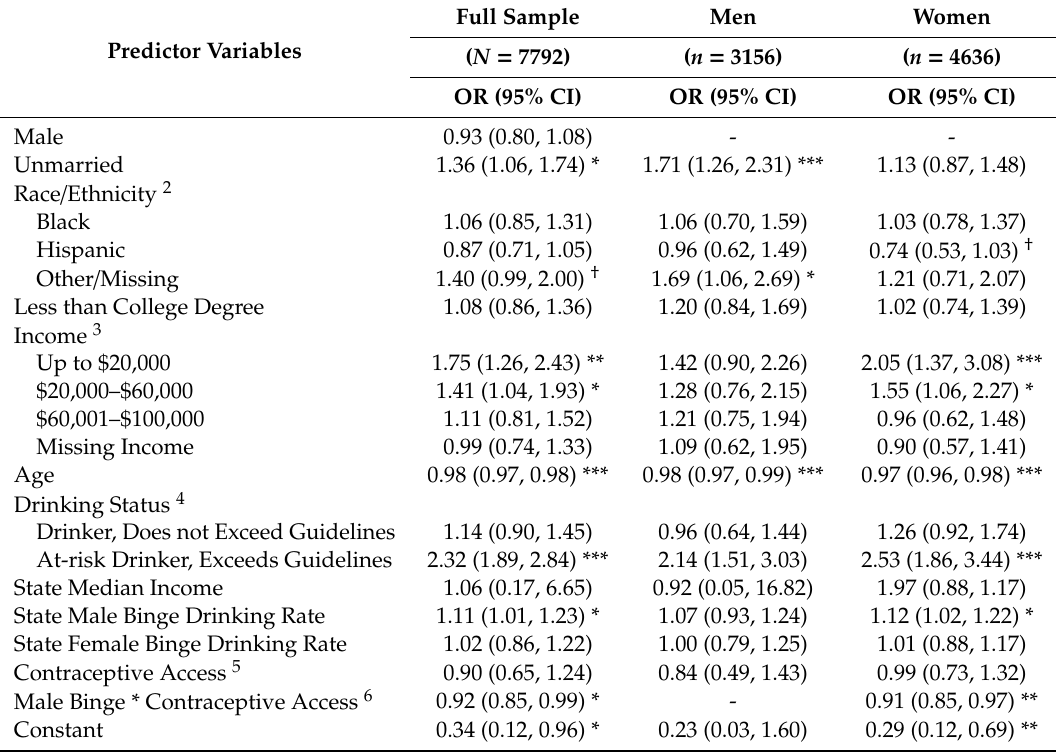
Table 2. Interactive associations of states’ male binge drinking rates and contraceptive access with any second-hand harm from others’ drinking 1